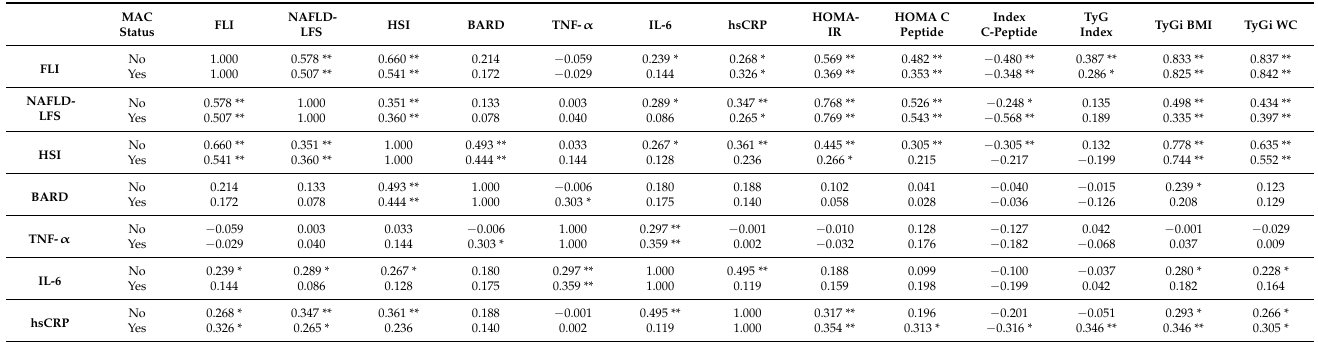
Table 3. Statistical associations between biomarkers for the two studied groups of diabetes patients without and with mitral annular calcification.